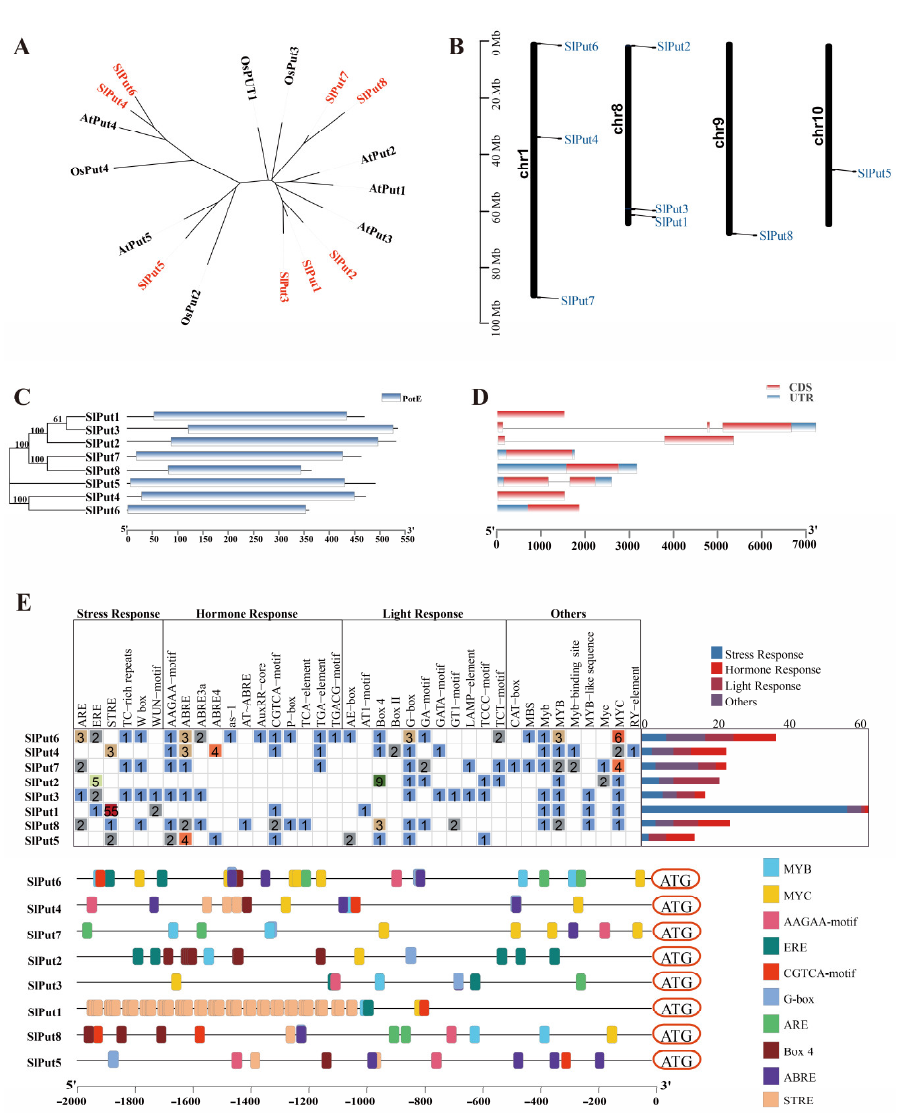
Figure 1. The characteristics of Put genes in the tomato. ( A ) Phylogenetic relationships of Put genes in Arabidopsis, rice, and tomato. ( B ) Gene distribution within the tomato chromosomes. The chromosome numbers are indicated on the left, and the position marked in the chromosome indicates the location of Put genes. ( C ) The protein motifs and phylogenetic trees in the Put famous members. ( D ) Gene structure of the Put family members in tomatoes. ( E ) Cis element distribution of the Put genes.